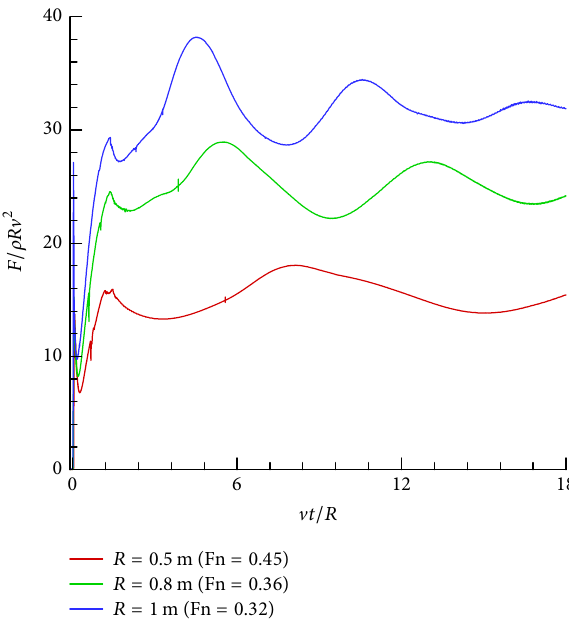
Figure 12: Fluid forces with different wave heights.